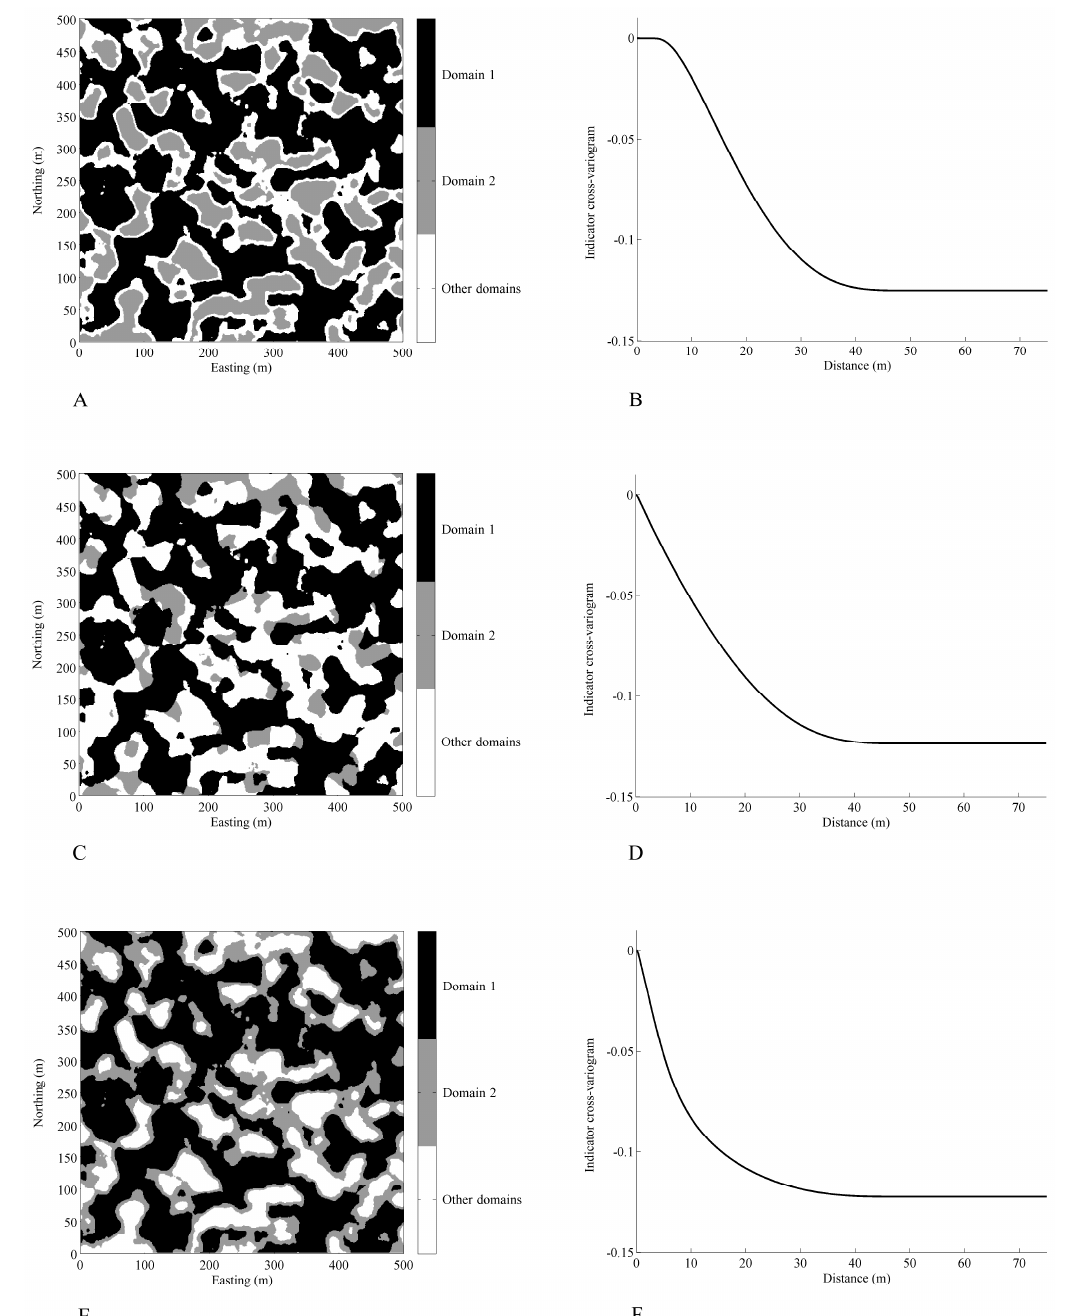
Figure 3. Plan views of geological domains ( A , C , E ) and indicator cross-variograms of domains D 1 and D 2 ( B , D , F ). The surface area of the contact between domains D 1 and D 2 is reflected in the first-order derivative of the indicator cross-variogram at the origin: no contact between domains ( A ) associated with a zero cross-variogram slope at the origin ( B ); existence of a contact with a small surface area ( C ) associated with a small negative cross-variogram slope at the origin ( D ); existence of a contact with a large surface area ( E ) associated with a large negative cross-variogram slope at the origin ( F ).